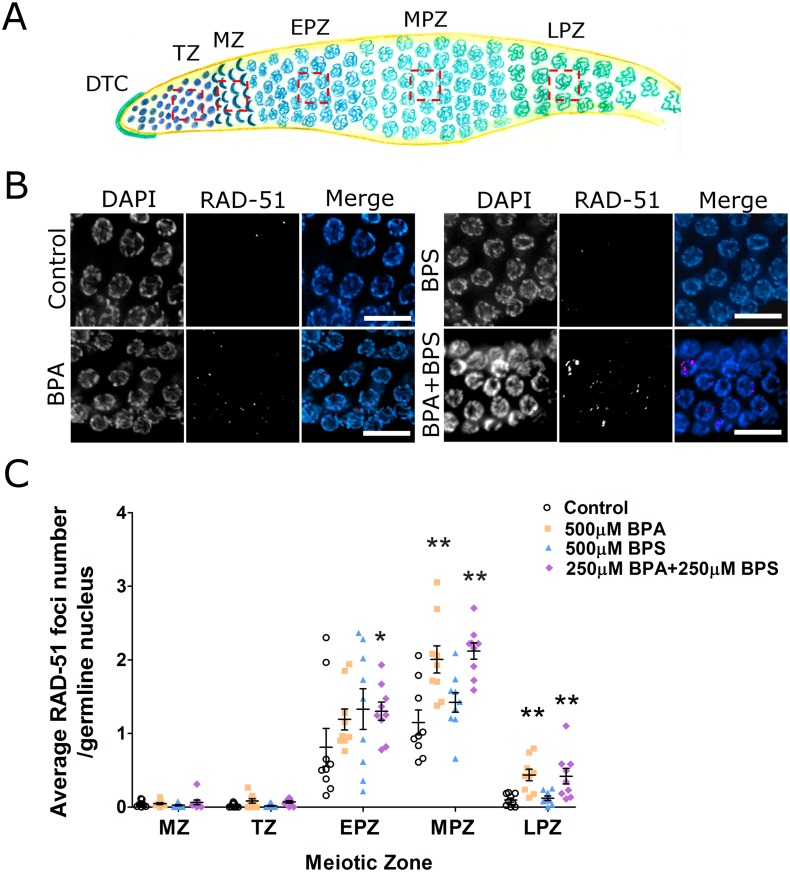
BPS does not alter the turn-over of DSBR protein RAD-51 in late pachytene.(A) Schematic representation of each meiotic stage in C. elegans germline. Each red square represents the area used for scoring RAD-51 foci. MZ: mitotic zone, TZ: transition zone, EPZ: early pachytene zone, MPZ: middle pachytene zone, LPZ: late pachytene zone. (B) Immunostaining of LPZ RAD-51 foci exposed to vehicle control (0.1% ethanol), 500 μM BPA, 500 μM BPS or to their mixture (250 μM BPA + 250 μM BPS). RAD-51 levels in LPZ are elevated in BPA and mixture but not BPS exposed or control group (scale bar, 10μm). (C) Quantitation of RAD-51 foci per germline nuclei of vehicle (0.1% ethanol) and bisphenols -exposed gonads. The average number of RAD-51 foci per nucleus with SEM (y axis) in each prophase I meiotic stage (x axis). N = 3 worms per group, three repeats per treatment group. All tests are based on t statistics. *P<0.05 and **P<0.01.